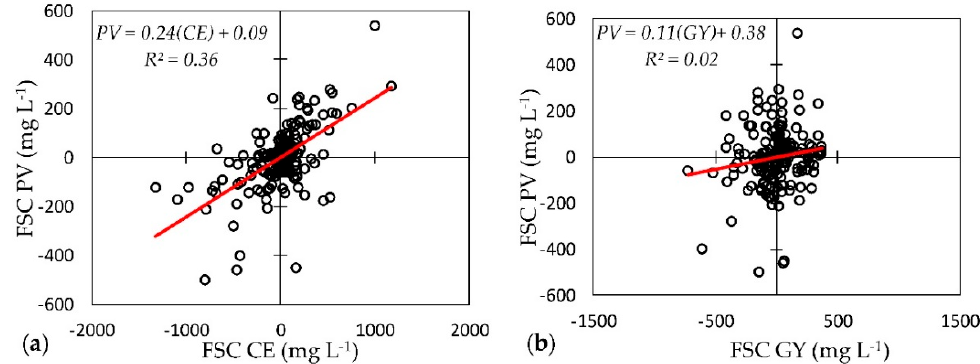
Figure 4. The 2003–2017 mean anomalies for the fine suspended sediment concentrations. ( a ) CE in the Beni River, related to PV in the Madeira River; ( b ) GY in the Mamoré River, related to PV.